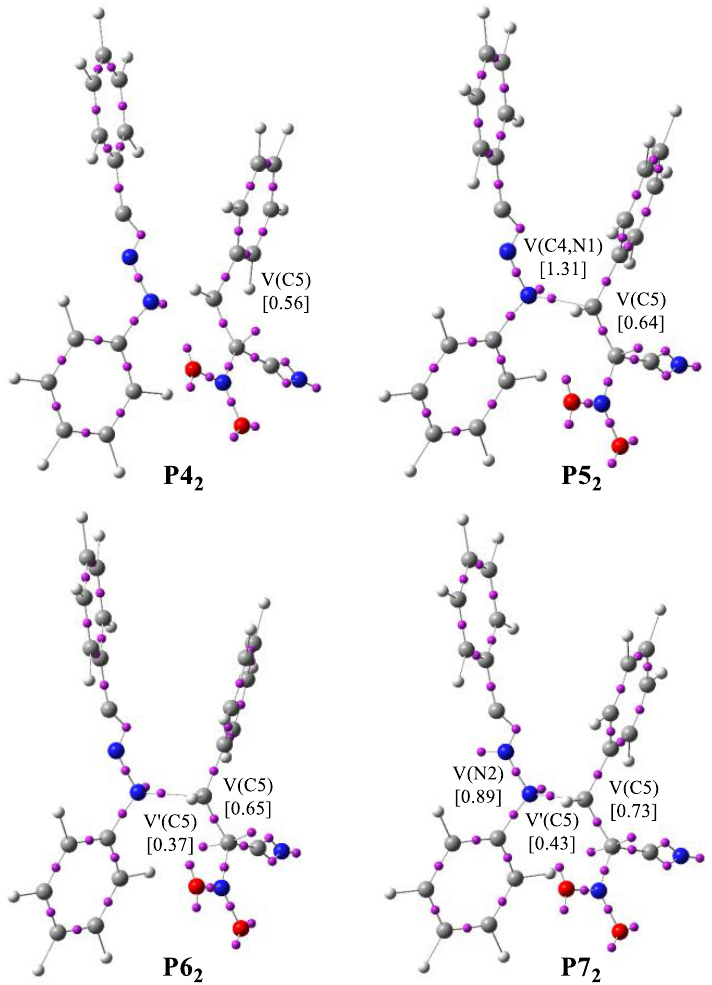
Figure 5. The main ELF valence basin populations for the points P4 2 – P7 2 participating in the formation of Z1 .